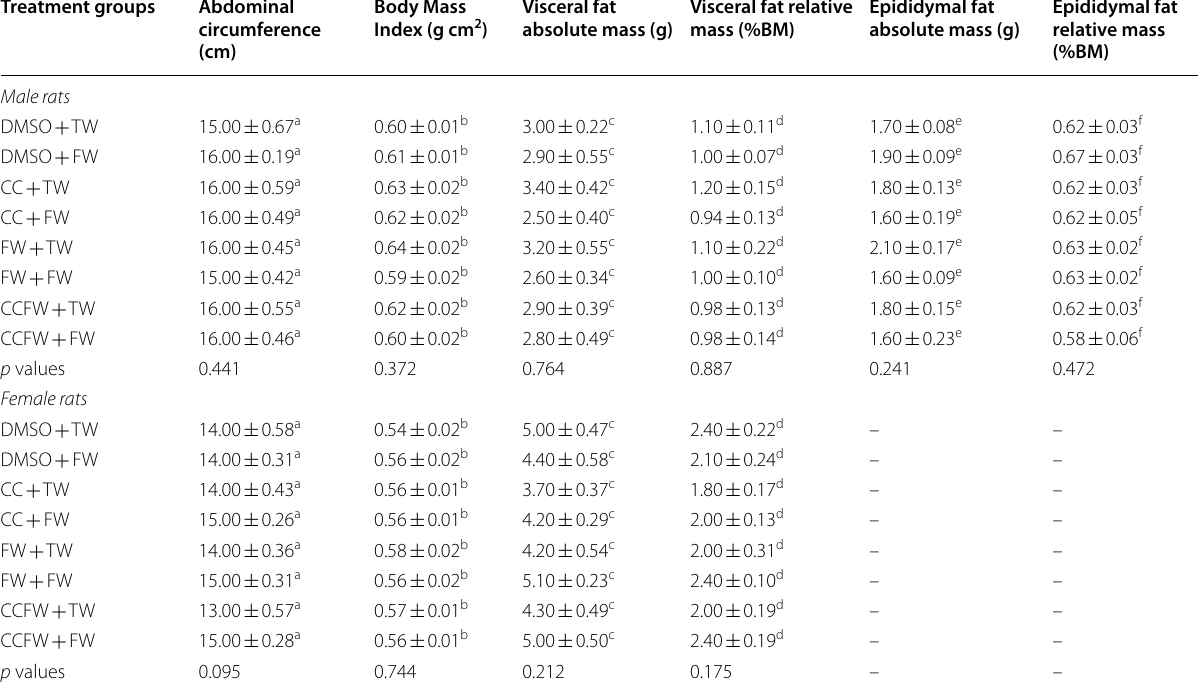
a, b, c, d, e, f Means across columns (in males and females) with similar superscripts are similar ( p > 0.05) using one-way ANOVA across all eight groups for abdominal circumference, BMI, absolute (g) and relative (BM) visceral fat mass, absolute (g) and relative (BM) epididymal fat pad mass of the male and female rats. BM